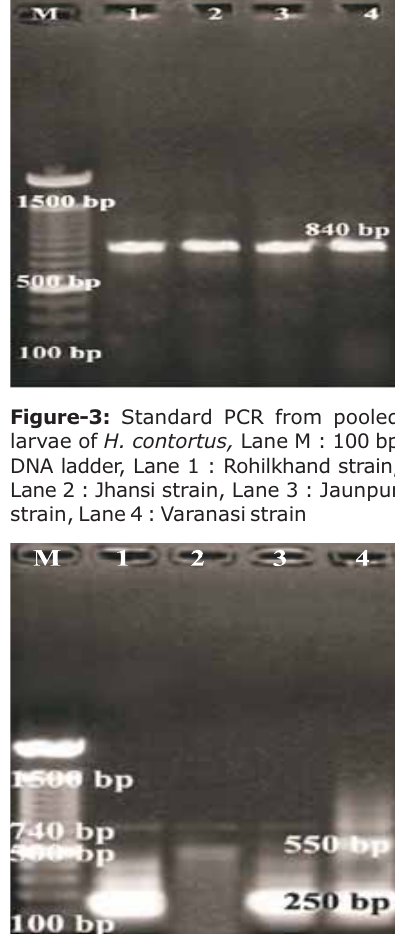
H. Figure-5: RFLP with RSa1 enzyme of L H. contortus, Figure-6: AS PCR of L of 3 3 H. contortus, Lane M : 100 bp DNA ladder, Lane 1 : Lane M:100bpDNAladder, Rohilkhand strain, Lane 2 : Jhansi strain, Lane 1 : Rohilkhand strain, Lane 2 : Jhansi Lane3: Jaunpur strain, Lane4: Varanasi strain, Lane 3 : Jaunpur strain, Lane 4 : strain Varanasi strain